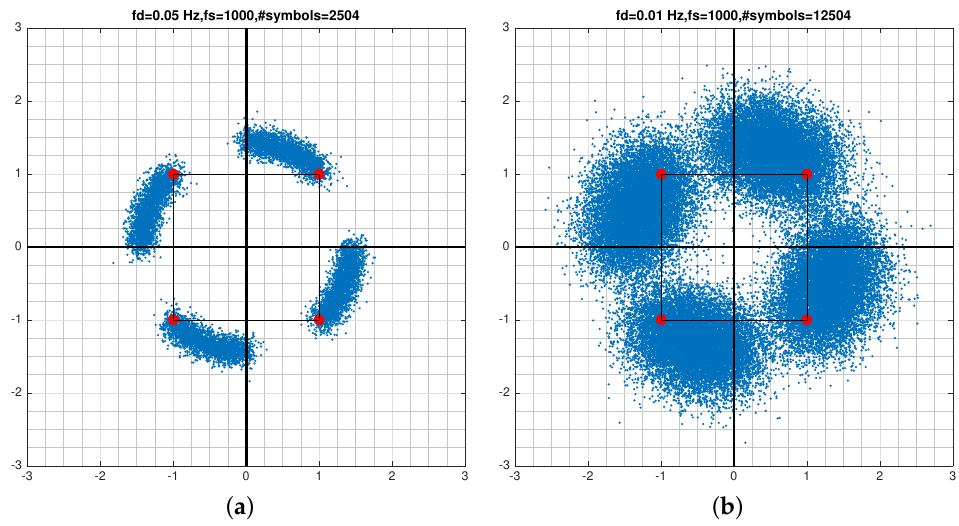
Figure 4. Constellation smearing caused by time-varying phase offset under two SNR values. ( a ) SNR = 20 dB, ( b ) SNR = 10